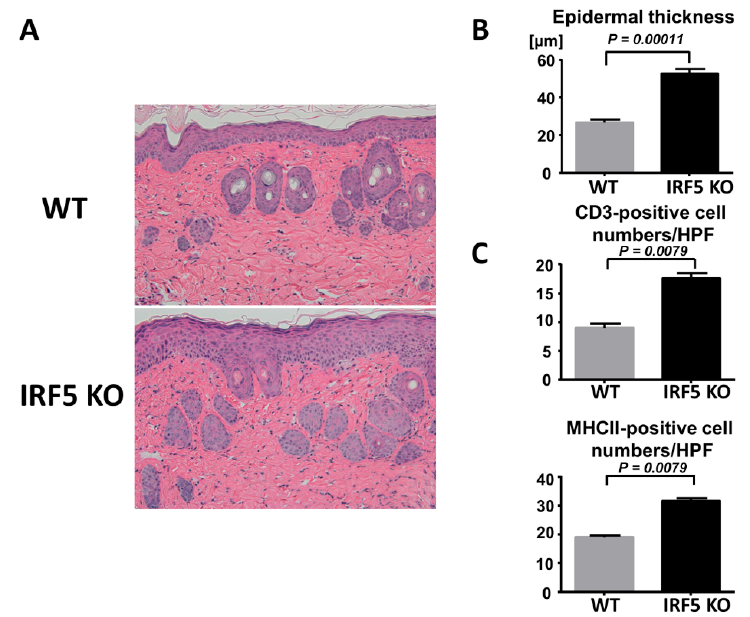
Figure 2. Epidermal hyperplasia and inflammatory cell infiltration are enhanced in IRF5-deficient mice. ( A ) Histological presentation stained with hematoxylin and eosin (HE) of wild-type (WT) and knockout (IRF5 KO) mouse back skin induced by imiquimod application at day 5 ( × 200) Representative pictures from 9 mice per group. ( B ) Epidermal thickness was measured. ( C ) The numbers of CD3 + cells and major histocompatibility complex class II (MHCII)-positive cells were counted per high-power field. Data are presented as the mean ± SEM of three independent experiments ( n =